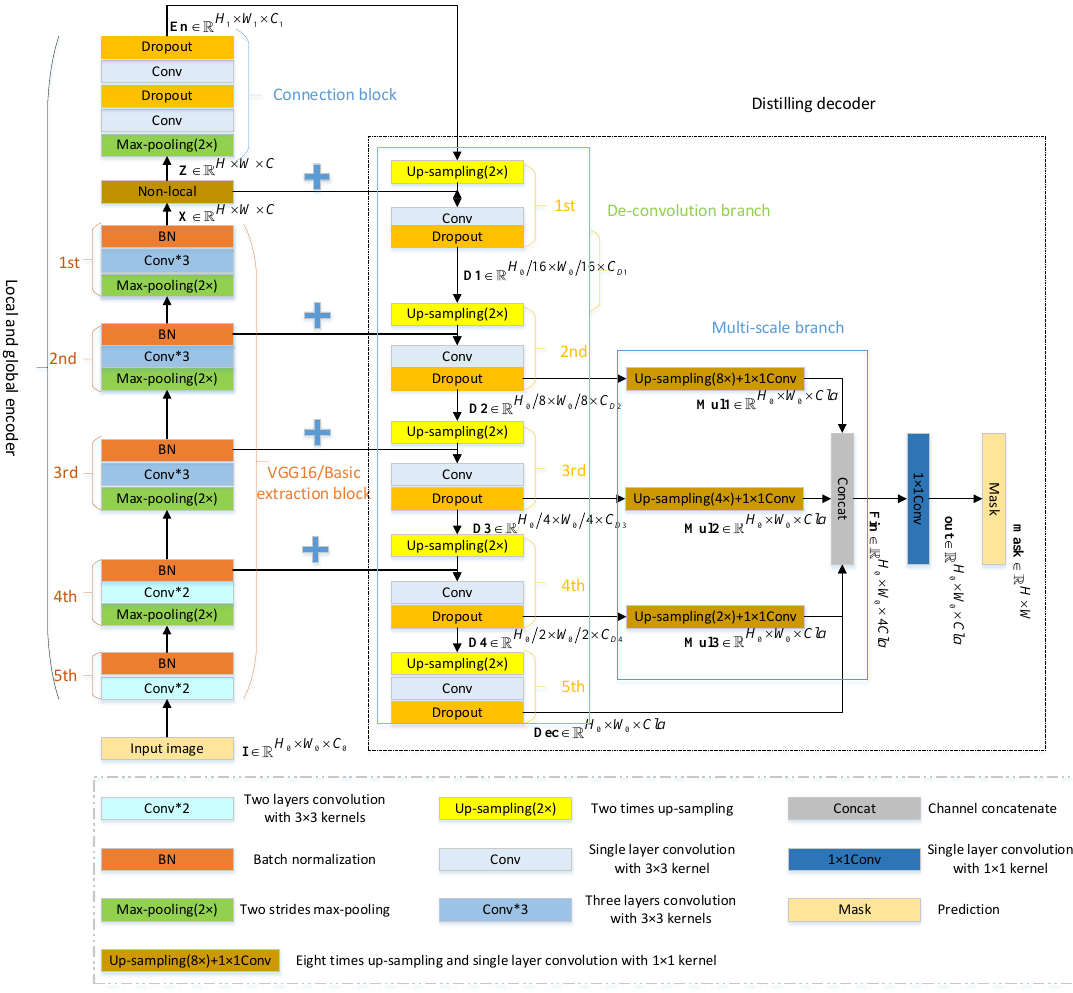
Figure 1. Framework of our global multi-scale encoder-decoder network